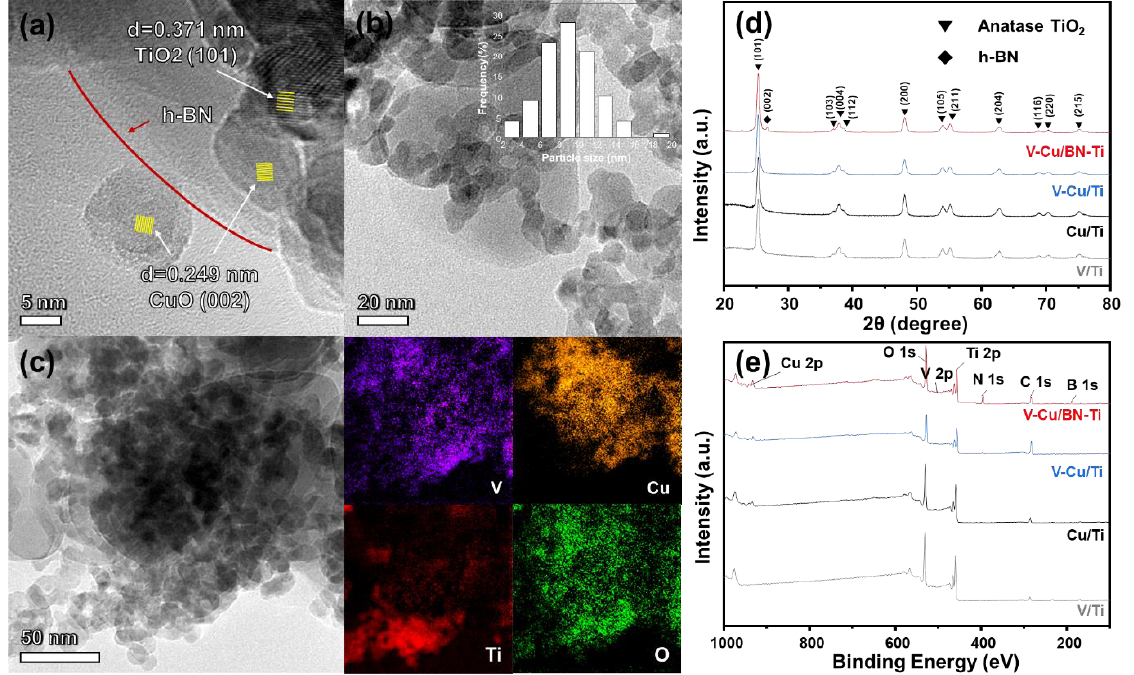
Figure 1. ( a ) High magnification TEM image, ( b ) TEM image and histogram of particle size distri- bution, ( c ) EDS mapping for V-Cu/BN-Ti, ( d ) XRD patterns, ( e ) XPS survey scan for V/Ti (gray line), Cu/Ti (black line), V-Cu/Ti (blue line), and V-Cu/BN-Ti (red